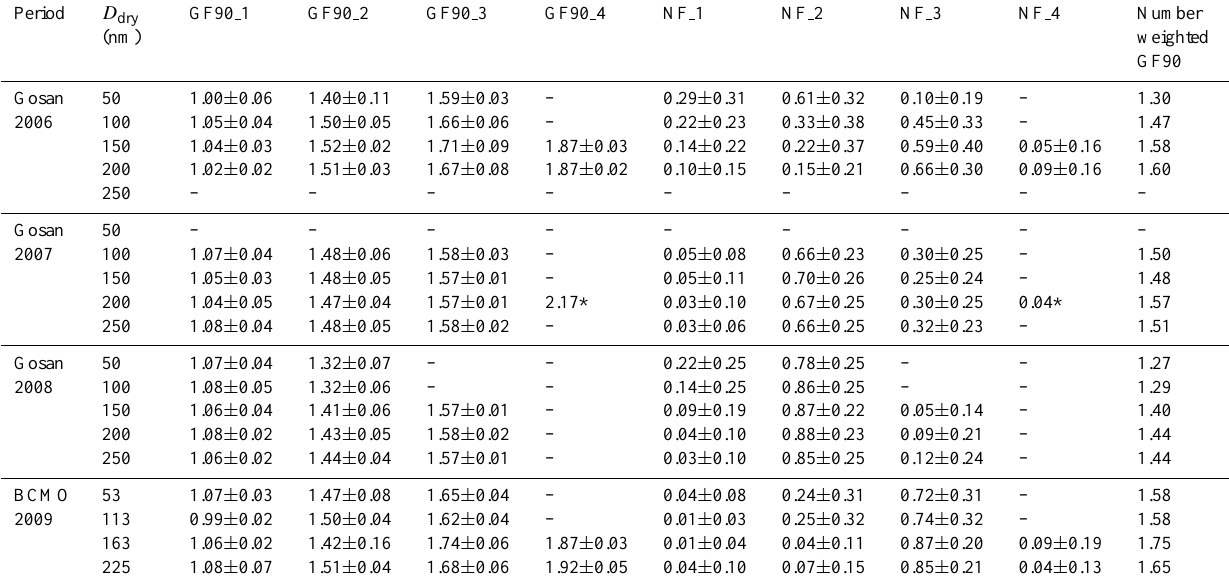
Table 2. Average and standard deviation of GF90 and cumulative number fraction (NF) of each hygroscopicity class; class 1, 2, 3 and 4 corresponds to “nearly hydrophobic”, “less hygroscopic”, “more hygroscopic” and “very hygroscopic”, respectively.